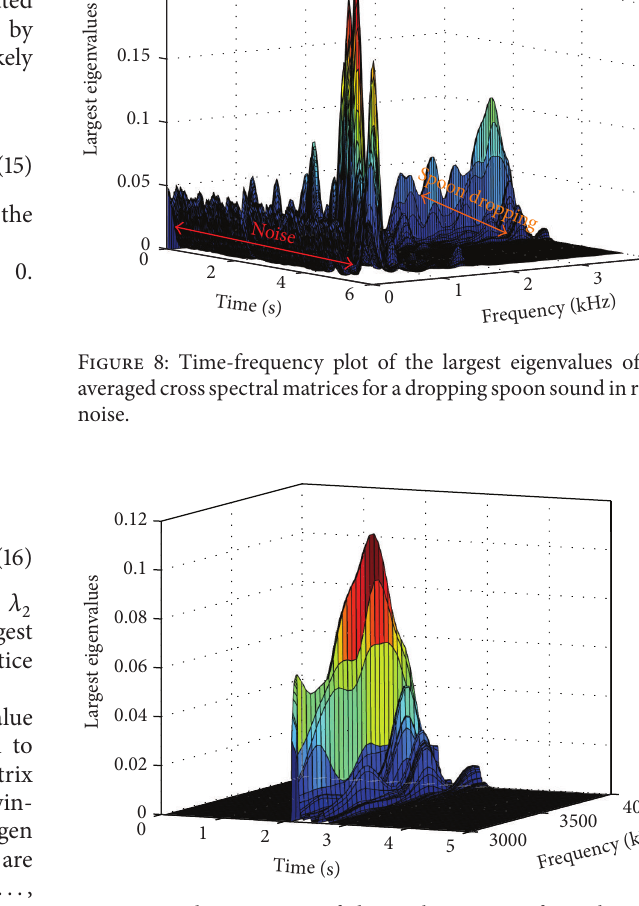
Figure 9: Close-up view of the 3-4 kHz region from the time- frequency plot in Figure 8. This shows a significant non-zero component when the SDL is